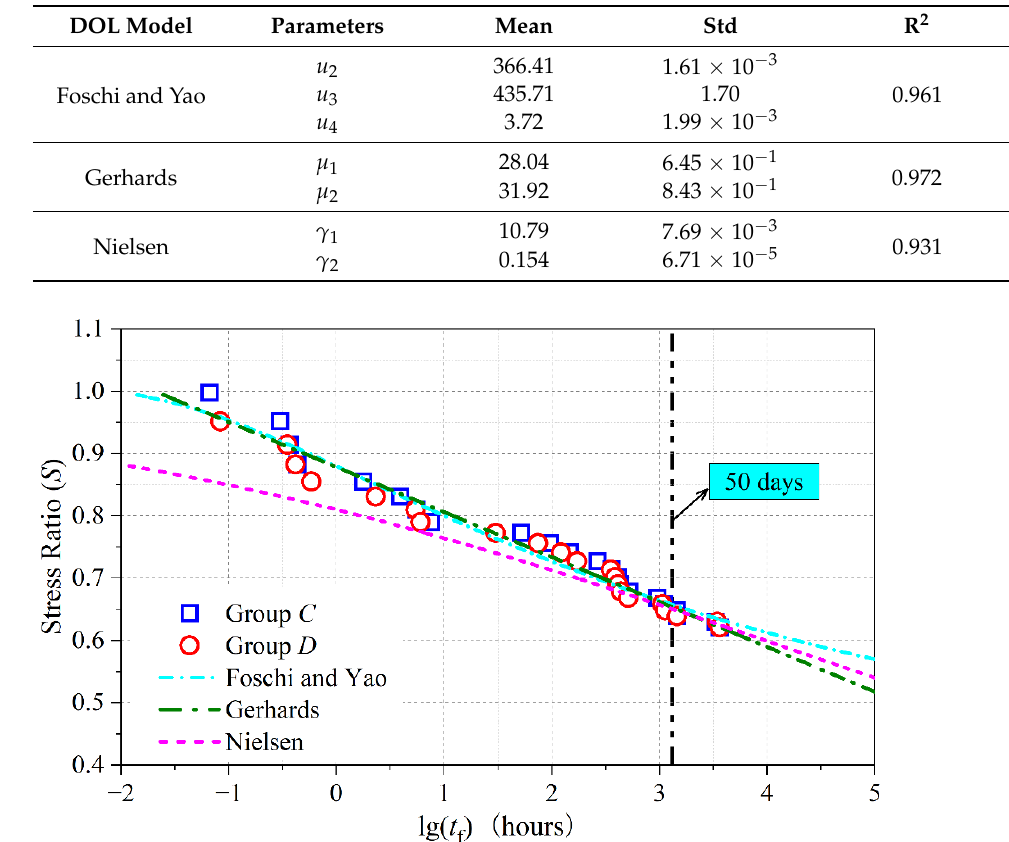
Figure 6. Fitted curves of DOL effect under constant load by different models.